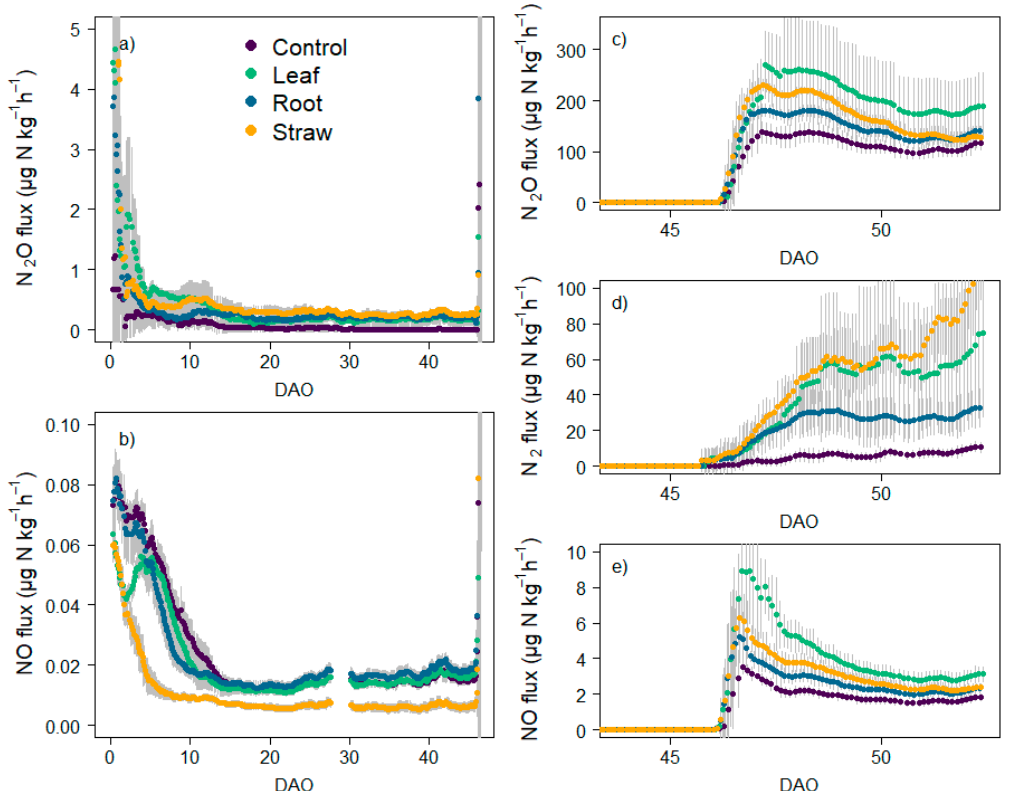
Figure 2. ( a , b ) N 2 O, and NO fluxes during oxic incubation period (0–47 DAO). ( c – e ) N 2 O, N 2 , and NO fluxes during anoxic incubation (47–55 DAO) of maize litter on grassland soil (means and standard deviation for n = 5, n = 4 for Control, when not visible, error bars are smaller than the symbols).